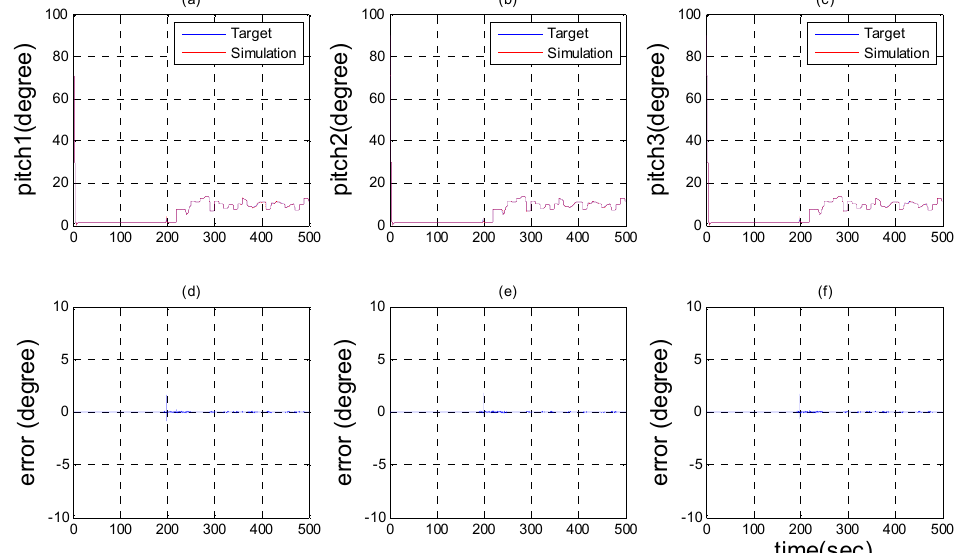
Figure 22. Pitch angle tracking control in Region 3: ( a ) Pitch 1; ( b ) Pitch 2; ( c ) Pitch 3; ( d ) Pitch 1 tracking error; ( e ) Pitch 2 tracking error; ( f ) Pitch 3 tracking error.